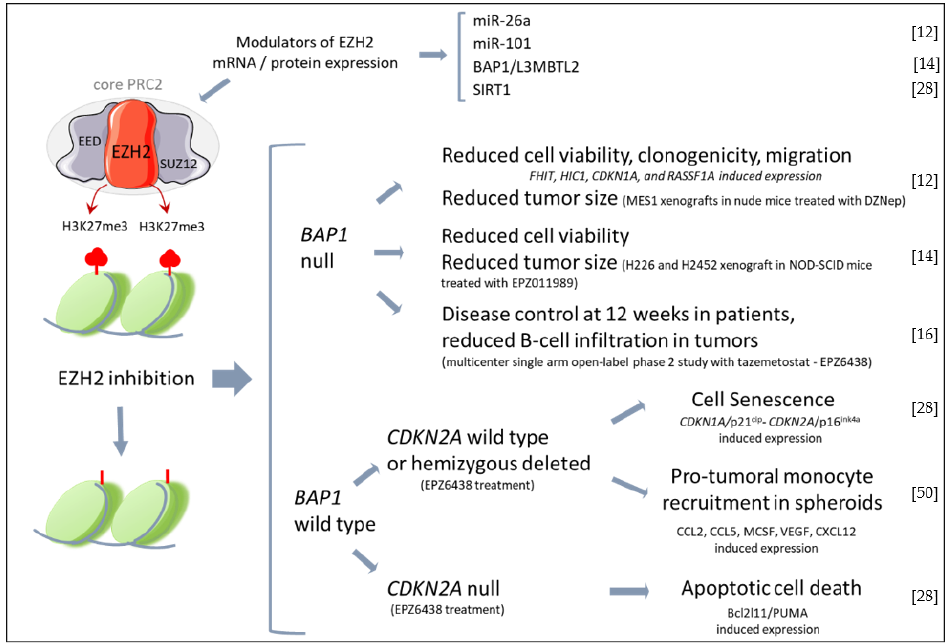
Figure 1. Effects of EZH2 inhibition in MPM. In the upper brace are reported miRNAs and proteins that have been described to modulate EZH2 expression in MPM cells. Below, the main effects of EZH2 inhibitors reported by in vitro and in vivo studies with MPM cells/tumors stratified by BAP1 or CDKN2A expression. (EZH2, enhancer of zeste homolog 2; EED, embryonic ectoderm development; PRC2, Polycomb re-pressor 2; SUZ12, suppressor of zeste 12 homolog; H3K27Me3, Histone 3 lysine 27 trimethylate; BAP1, BRCA1 associated protein 1; L3MBTL2, lethal 3 malignant brain tumor-like protein 2; SIRT1, sirtuin1; FHIT, Fragile Histidine Triad Diadenosine Triphosphatase; HIC1, HIC ZBTB Transcriptional Repressor 1, CDKN1A , cyclin dependent kinase inhibitor 1A; RASSF1A, Ras as-sociation domain family 1 isoform A; MCSF, macrophage colony stimulating